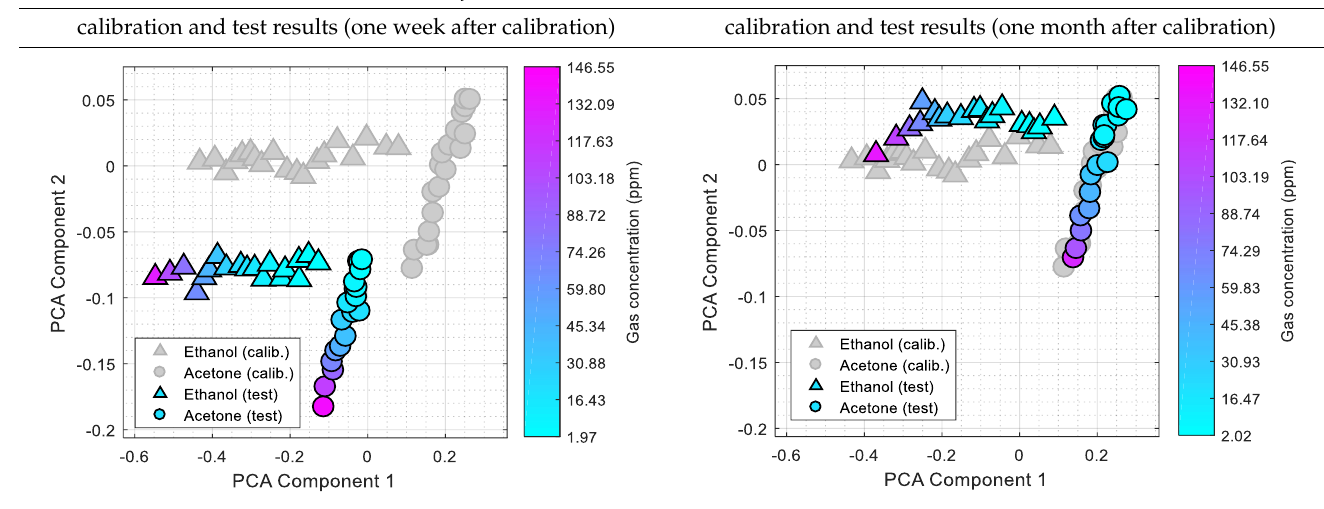
Table 3. Calibration data of ethanol (triangle, gray) and acetone (circle, gray) are represented using the PCA projection obtained from this calibration data. Comparative projection of additional test data of ethanol (triangle, colored) and acetone (circle, colored) obtained one week (left column) and one month (right column) after the calibration. The absolute concentration of the volatiles measured during the tests is depicted with the attached color-map scale. 2D PCA Projection of the eNose Data (Evaluated as Resistance, R ) calibration and test results (one week after